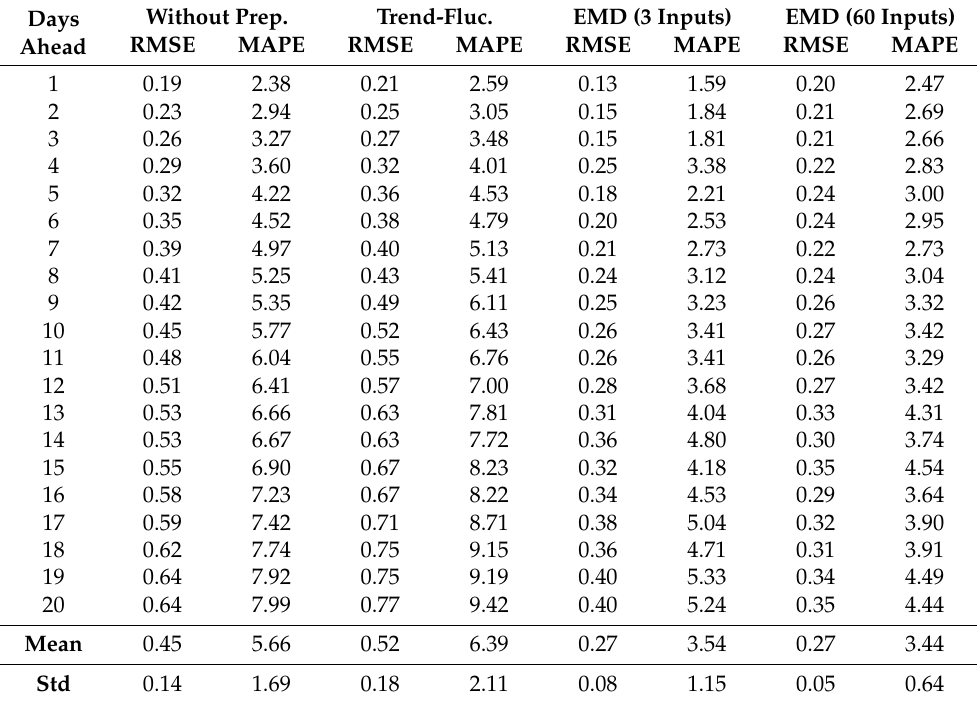
Table 3. Predictions with MLP for the reduced data set (2009–2016). 60% of them were used for training and 40% for validation. Data have been scaled with standardization for “Without Prep.” and “Trend-Fluc.” and with Min-Max for EMD. Without Prep.